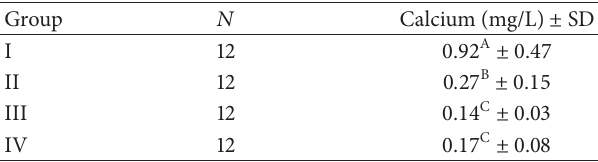
Table 2: The mean values and standard deviations of released calcium into acid solution per